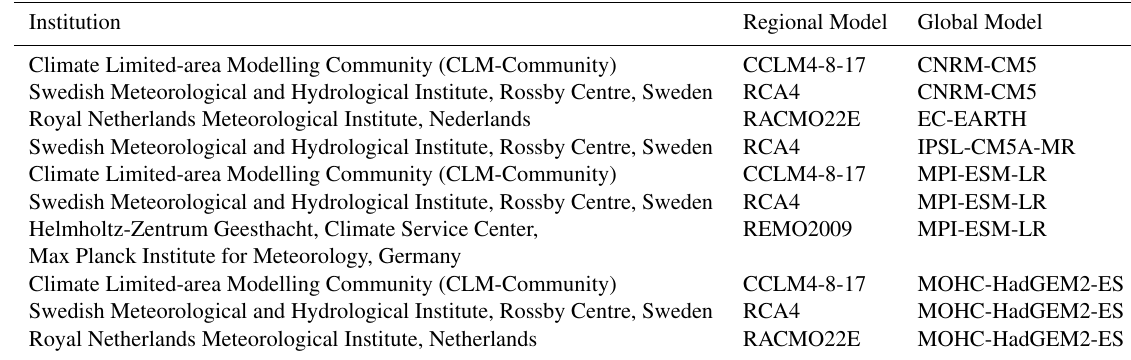
Table 4. List of CORDEX models used in the 3rd delivery of Regional Projections by